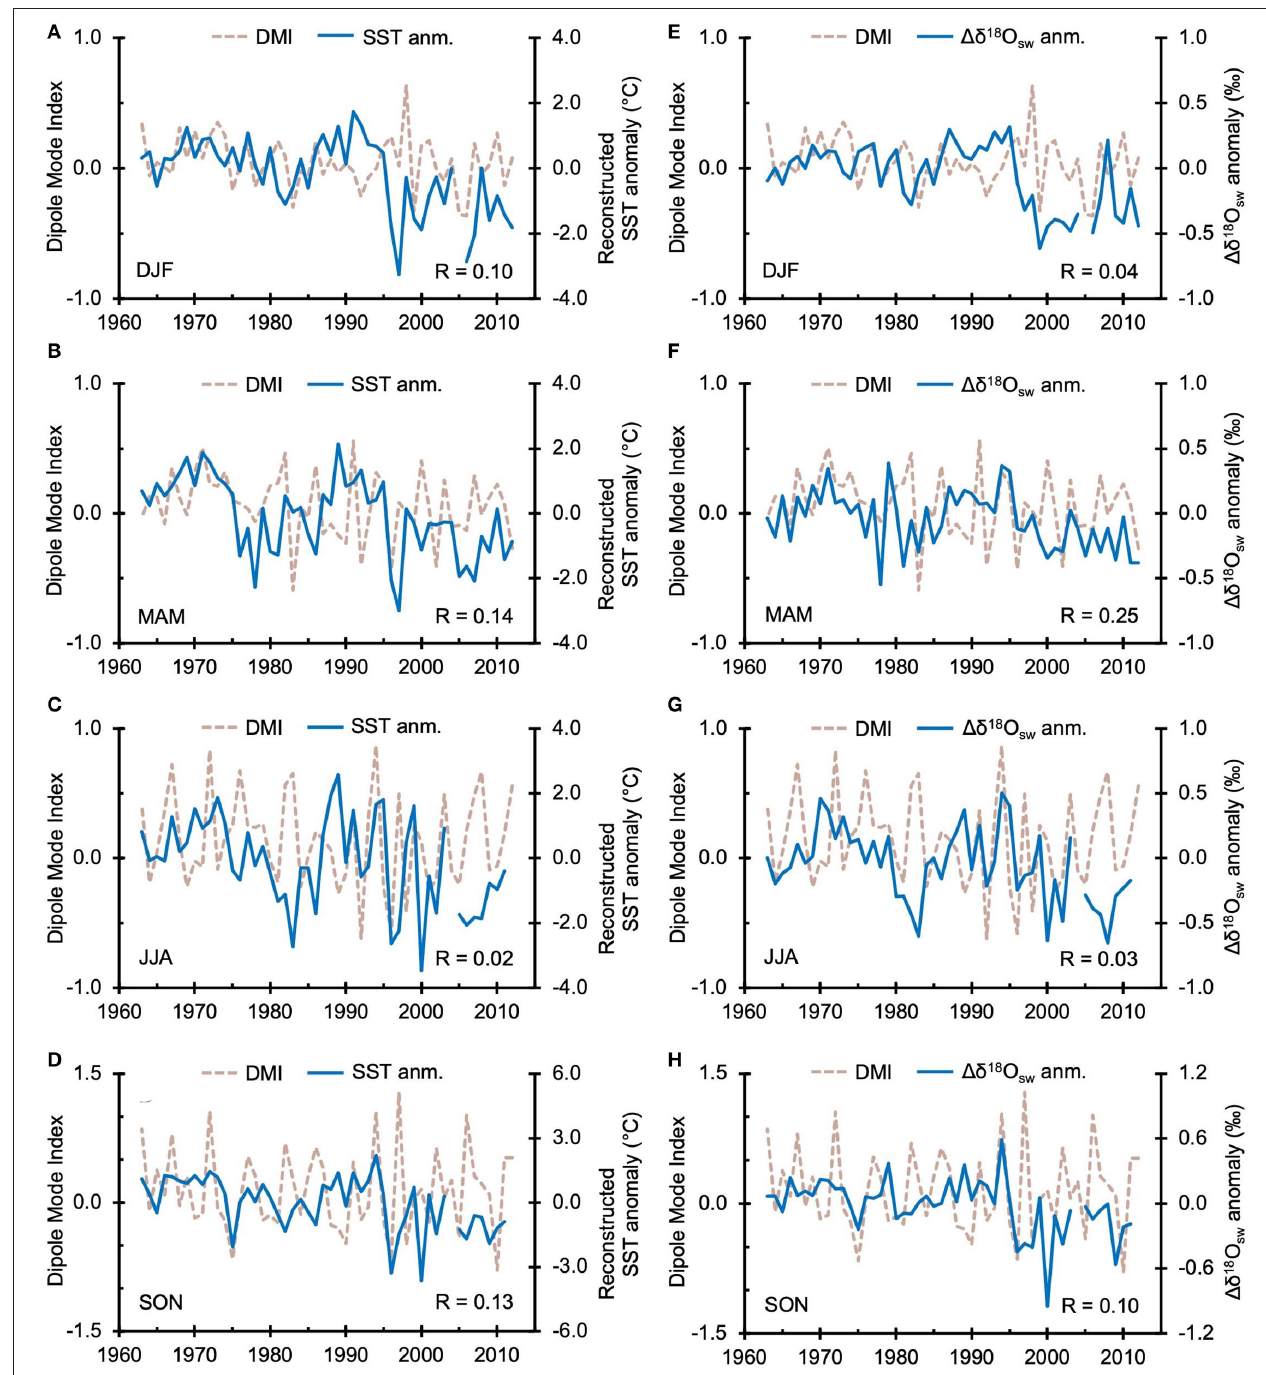
FIGURE 8 | Seasonal Dipole Mode Index (DMI) compared with seasonal SST anomaly (left panels) and seasonal 1 δ 18 O sw anomaly (right panels): (A,E) DJF, (B,F) MAM, (C,G) JJA, and (D,H)